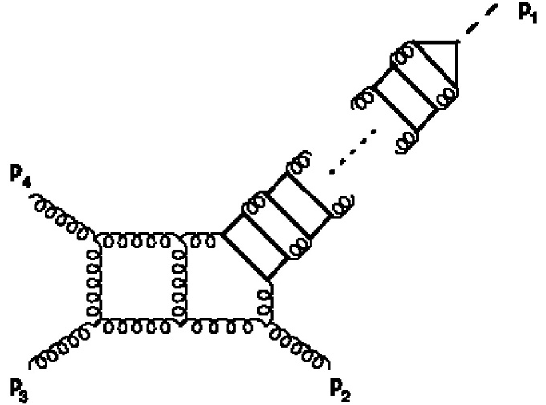
Figure 23. Planar box-rocket diagram contributing to H + j